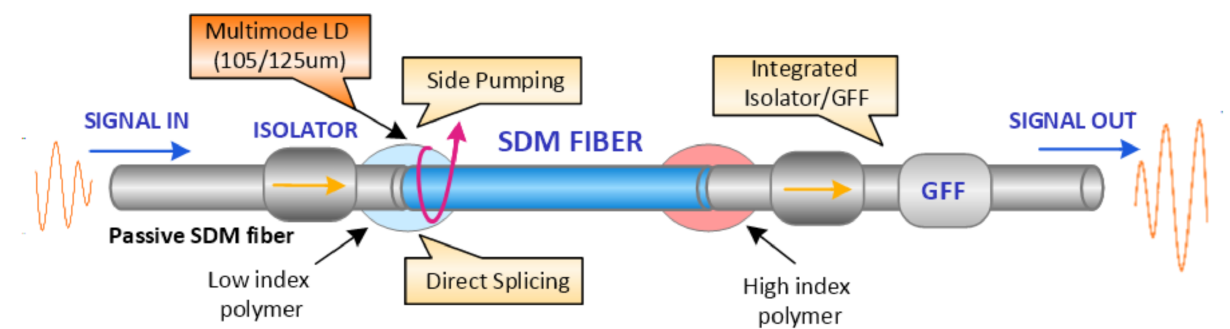
Figure 23. × Tb/s schematic of a fully integrated SDM EDFA